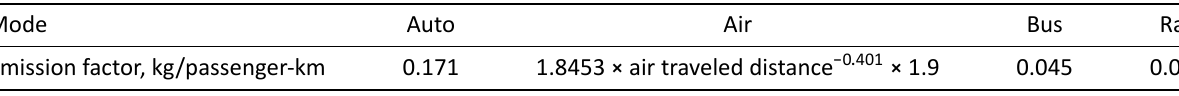
Table 5. Emission factors for long‐distance modes.